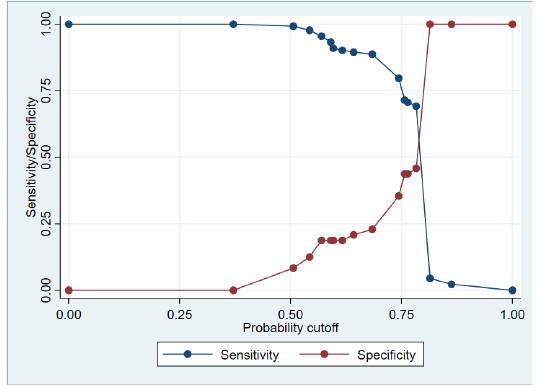
Fig. 1. Cut off value for North Pan American road accidents Fig. 2. the optimal value where it was possible to maximize sensi-